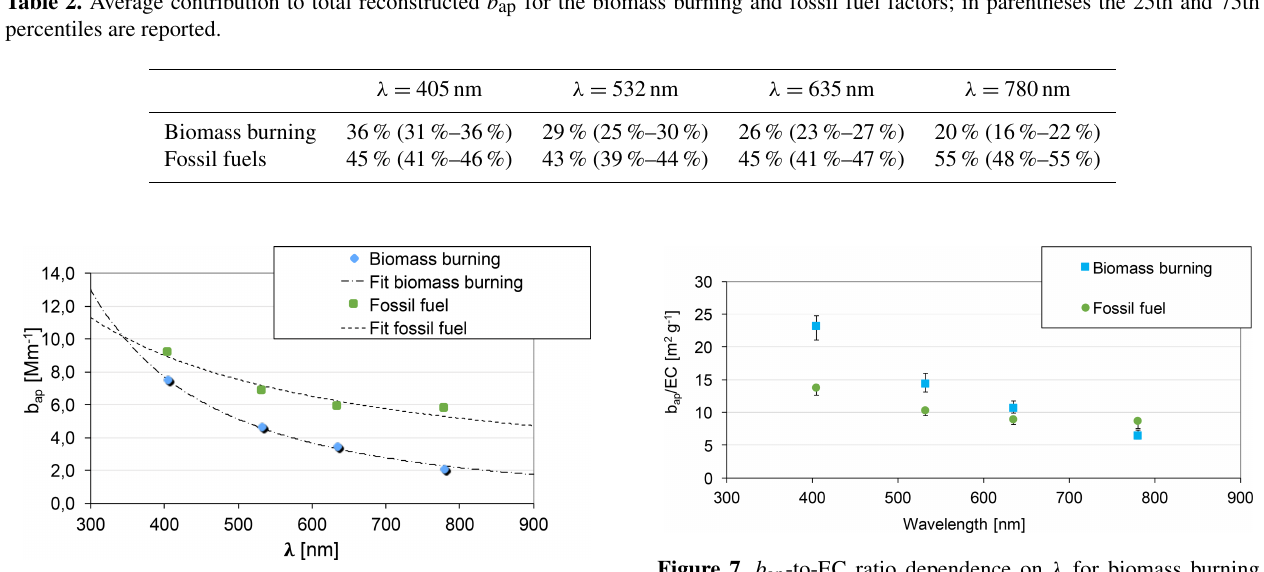
Figure 6. b ap dependence on λ for biomass burning and fossil fuel emissions.